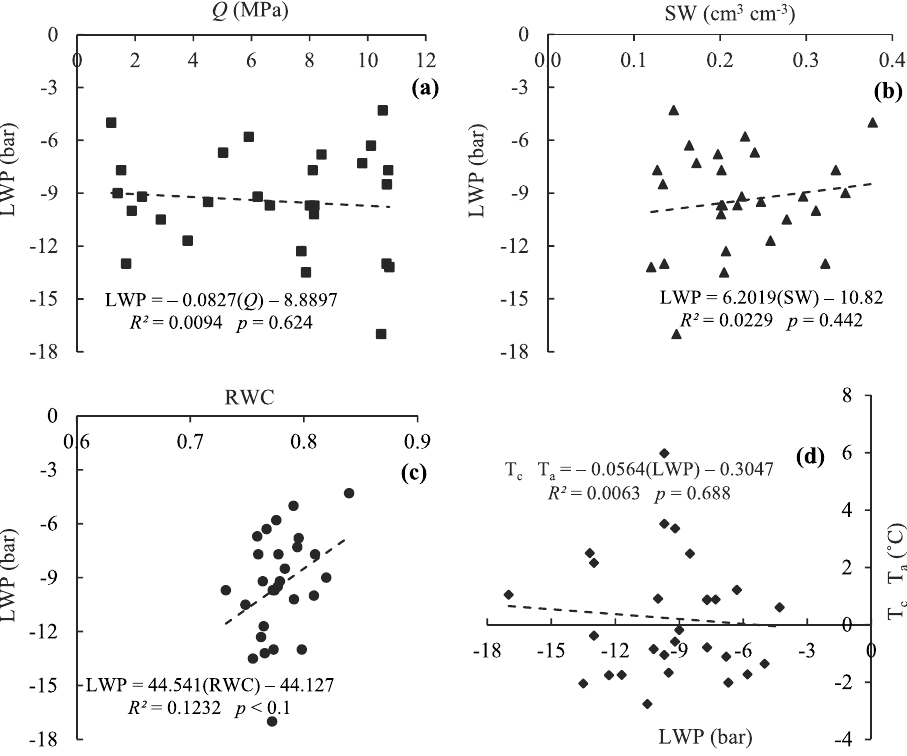
Figure 7. Linear relations between LWP and Q ( a ), LWP and SW ( b ), LWP and RWC ( c ), and (T c − T a ) and LWP ( d )